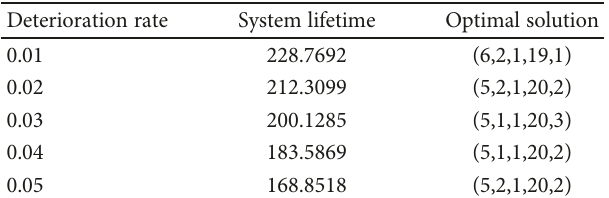
Figure 4: System lifetime versus simulation times in the UOVOM. Table 5: Optimal solutions for di ff erent deterioration rates in the